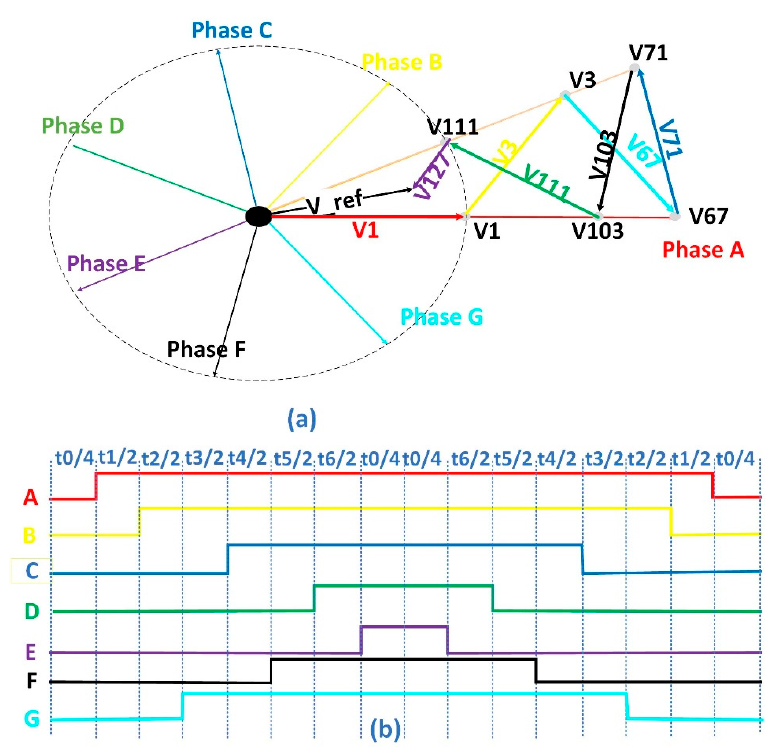
Figure 3. ( a ) NSV ‐ SVPWM vector synthesis in x1 ‐ y1, ( b ) PWM waveform [38]. Figure 3. ( a ) NSV-SVPWM vector synthesis in x1-y1, ( b ) PWM waveform